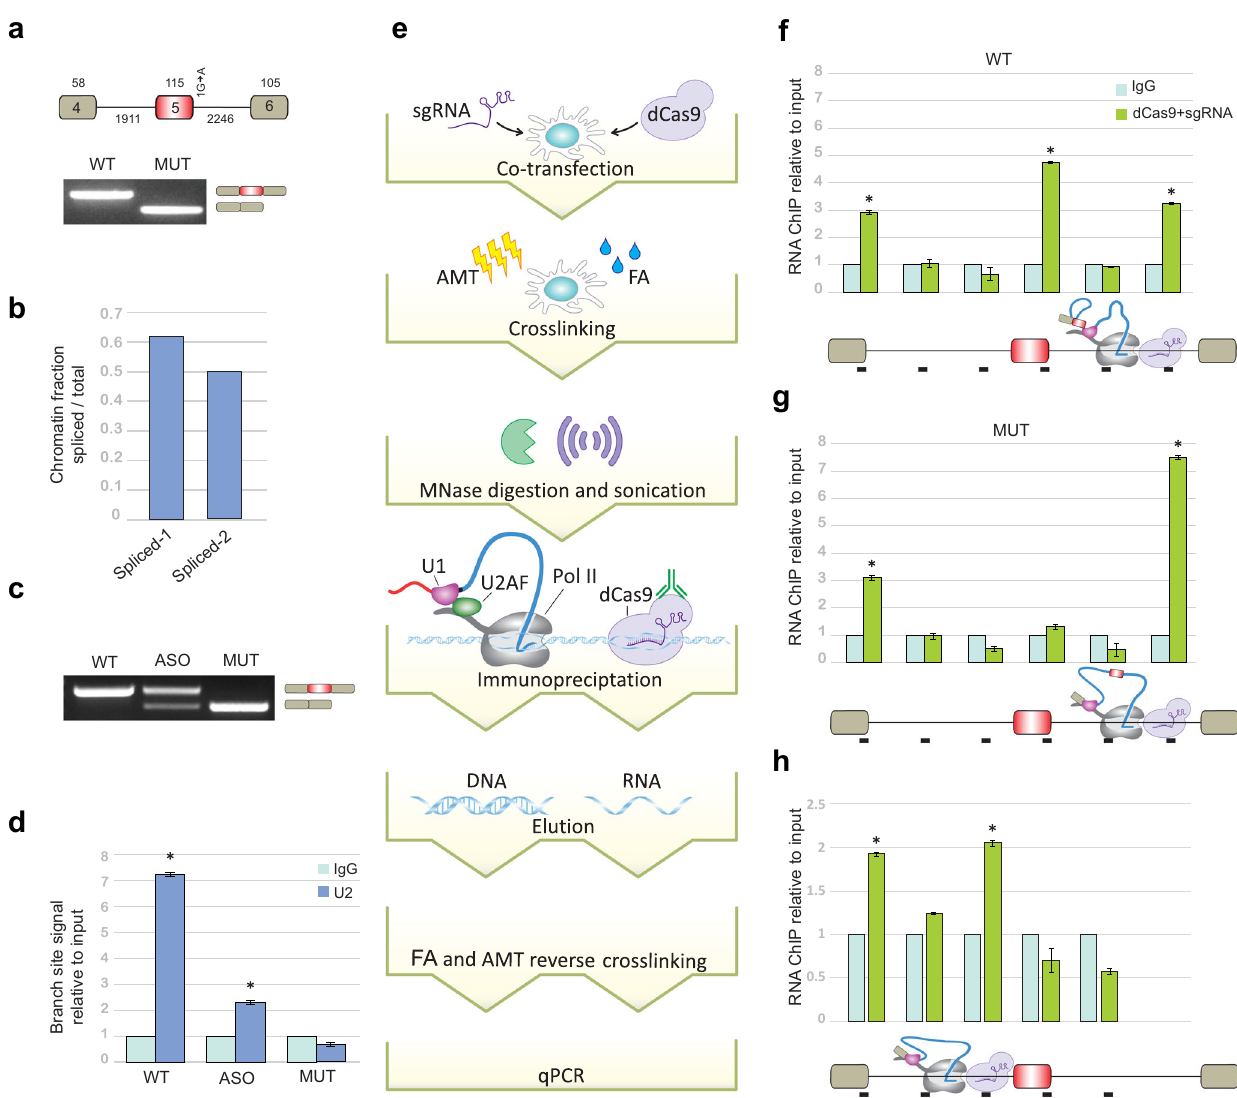
Fig. 1 The 5 ′ SS regions of pre-mRNAs are associated with pol II located in the middle of the downstream intron. a Upper panel: Diagram of FRG1 minigene. 5 ′ SS + 1 position mutation from G to A. Exon numbers and the exon and intron lengths are indicated. Lower panel: RT-PCR analysis of FRG1 WT and MUT cells. Source data are provided as a Source Data fi le. b Amount of chromatin-associated RNA determined by qRT-PCR with exon – exon junction quantity divided by the sum of exon – exon and exon – intron junctions quantity 29 . One experiment was done. Spliced-1 denotes the exon 1 – exon 2 junction and Spliced-2 denotes the exon 2 – exon 3 junction. c Cells that express WT FRG1 were treated with or without 750 nM of antisense oligonucleotide (ASO) complementary to the 5 ′ SS region of intron 2 of the FRG1 minigene. After 48 h, RNA was extracted, and the splicing pattern was examined by RT-PCR for ASO-treated cells, for WT and MUT cell lines. d RNA-ChIP analysis with anti-U2 snRNP antibody and IgG antibody as negative control were performed in WT, WT ASO-treated, and MUT cells. qRT-PCR was performed to quantify the amount of branch-site region from the fi rst intron that was precipitated. N = 3 independent experiments. Error bars show mean values ± SD. Asterisk indicates for WT P = 0.006 and for ASO P = 0.005, two-tailed t -test. e Schematic overview of our CRISPR interference-based protocol. Cells are co-transfected with plasmids for expression of HA – dCas9 and sgRNA complementary to the desired location in a gene. After 48 h, cells are treated with FA and AMT, and nuclei are puri fi ed. Chromatin is digested with MNase and sonicated. Immunoprecipitation is performed with an anti-HA antibody, followed by RNA or DNA extraction, and real-time PCR analyses. f – h CRISPR interference-based experiments were performed with anti-HA antibody and IgG antibody as a negative control to evaluate the association of various transcript regions with pol II located f mid-intron 2 of WT FRG1 , g mid-intron 2 of MUT FRG1 , and h mid-intron 1 of WT FRG1 . Mean RNA levels were measured. N = 3 independent experiments. Each bar corresponds to the ampli fi ed segment marked in the gene diagram below the graph. Error bars show mean values ± SEM. Asterisk indicates from left to right for f P = 0.002, 8 × 10 − 4 , 0.001, for g P = 0.01, 5 × 10 − 6 , for h P = 0.004, 0.02, two-tailed t